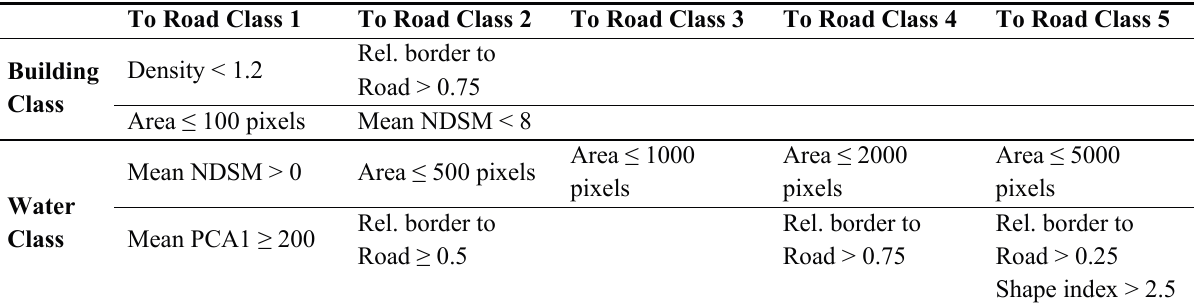
Table 4. Rules for reclassification of mislabeled building image objects and water image